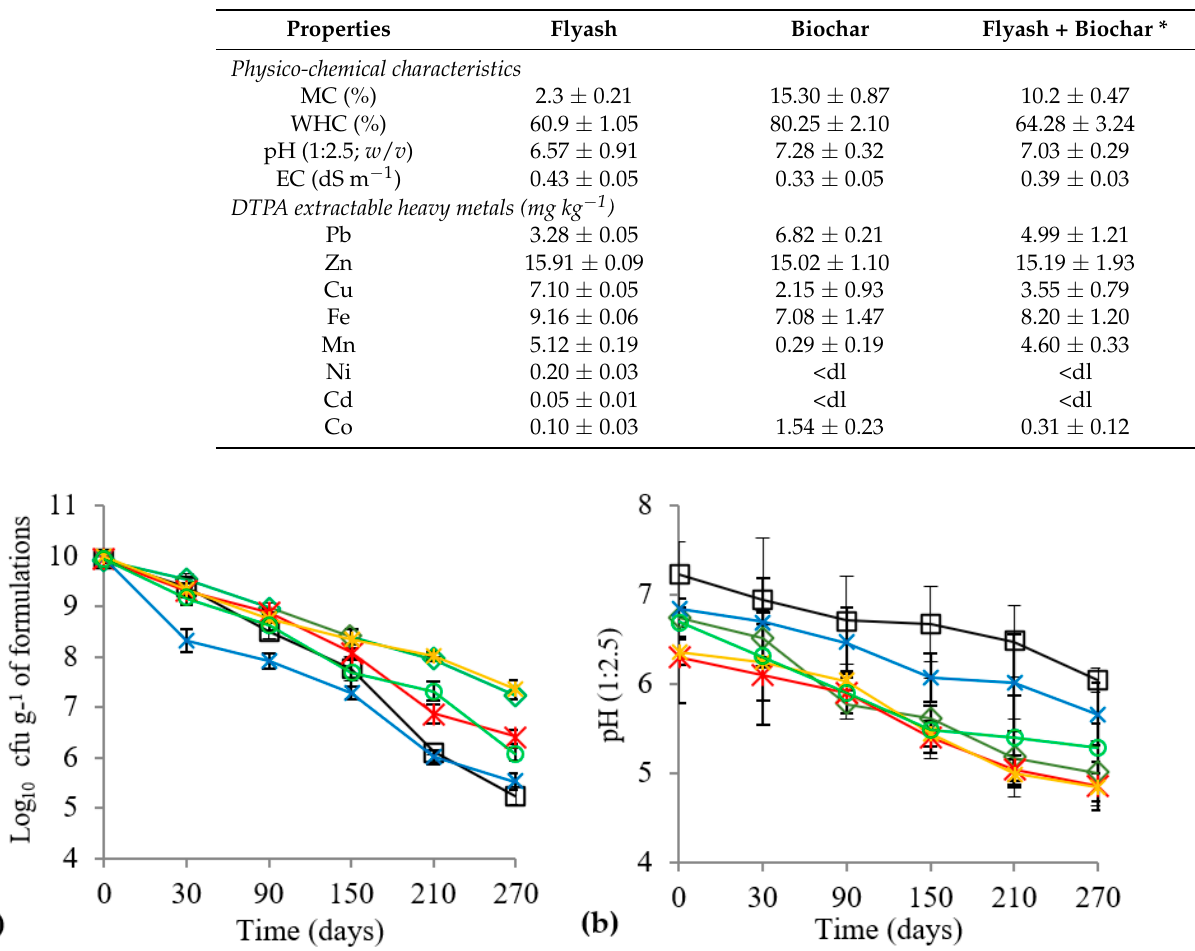
Table 2. Physicochemical properties and concentration of DTPA-extractable metals in two different carrier materials and in their mixture. (Mean ± SD; n = 3); <dL: detection limit; * Flyash + Biochar (1:1; w / w ). MC: moisture content; WHC: water holding capacity; EC electrical conductivity; DTPA: